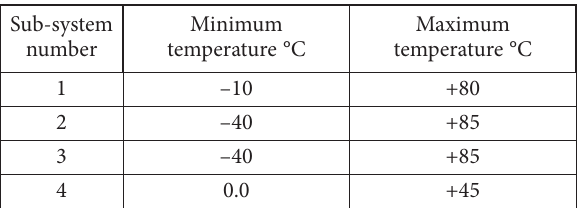
Table 1. Thermal requirements of the sub-systems